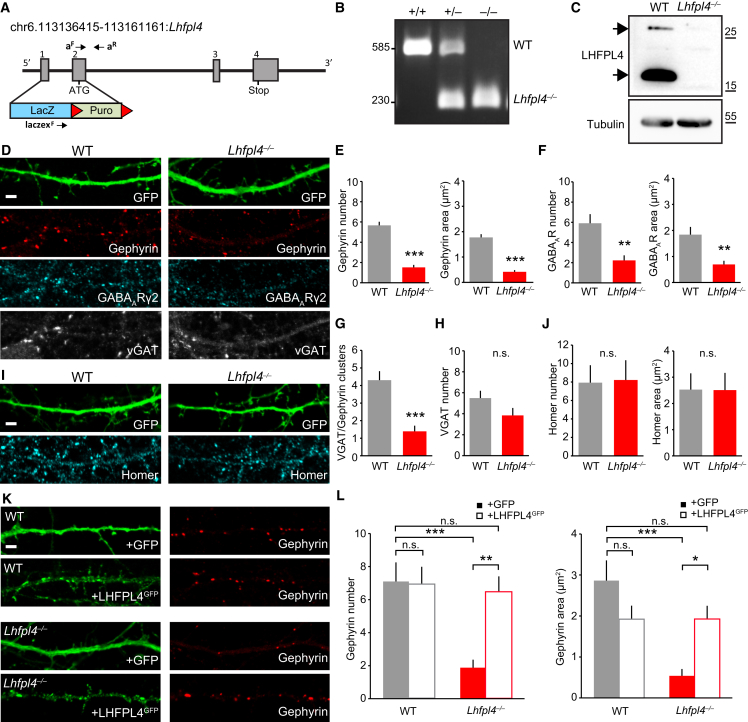
Loss of Inhibitory Synapse Stability and GABAAR Clustering in Lhfpl4−/− Neurons(A) Schematic of the LHFPL4 knockout genetic strategy showing the genotyping primer sites.(B) Genotyping results from WT (+/+), heterozygous (+/−) and homozygous (−/−) animals. The product of primers aF and aR generates a 585-bp band from the WT allele, and the product of laczexF and aR generates a 230-bp band from the Lhfpl4−/− allele.(C) Western blotting of LHFPL4 and tubulin from WT and Lhfpl4−/− mouse brain lysates. Arrowheads indicate the two LHFPL4-specific bands detected.(D and I) Confocal images of dissociated DIV14 (14 days in vitro) WT or Lhfpl4−/− hippocampal neurons transfected with GFP and labeled with antibodies to (D) gephyrin, GABAAR-γ2, and VGAT or (I) homer.(E–H and J) Quantification of (E) gephryin, (F) GABAAR-γ2, (G) VGAT/gephyrin, (H) VGAT and (J) homer synaptic clusters. Cluster number and total immunolabeled area were significantly reduced in Lhfpl4−/− neurons, compared to WT neurons, when labeled for gephyrin (cluster number: from 5.7 ± 0.4 to 1.5 ± 0.2; area: from 1.8 μm2 ± 0.1 μm2 to 0.4 μm2 ± 0.1 μm2; 484/166 WT/Lhfpl4−/− clusters; both p < 0.0001) and GABAAR-γ2 (cluster number: from 5.9 ± 0.9 to 2.2 ± 0.5; area: from 1.8 μm2 ± 0.3 μm2 to 0.7 μm2 ± 0.1 μm2; 636/327 WT/Lhfpl4−/− clusters; p = 0.0011 and 0.0013, respectively). VGAT/gephyrin-positive clusters were significantly reduced in Lhfpl4−/− neurons (from 4.3 ± 0.5 to 1.4 ± 0.3; 294/95 WT/Lhfpl4−/− clusters; p < 0.0001). VGAT cluster number did not significantly change (from 5.5 ± 0.7 to 3.8 ± 0.7; 531/403 WT/Lhfpl4−/− clusters; p = 0.103). In each case, n = 23 WT and 23 Lhfpl4−/− cells from 3 independent preparations. For WT and Lhfpl4−/− clusters, there was no significant change in homer cluster number (8.0 ± 1.9 and 8.2 ± 2.1, respectively; 333/345 WT/Lhfpl4−/− clusters) or area (2.5 μm2 ± 0.6 μm2 and 2.5 μm2 ± 0.7 μm2, respectively; n = 14 WT and KO cells from 3 independent preparations; p = 0.92 and 0.98, respectively). All used Welch t tests.(K and L) Confocal images (K) and cluster quantification (L) of GFP or LHFPL4GFP transfected WT or Lhfpl4−/− neurons labeled with a gephyrin antibody. LHFPL4GFP overexpression completely rescues the reduction of gephyrin cluster number (+GFP: WT, 7.1 ± 1.2; Lhfpl4−/−, 1.9 ± 0.5; 291/80 WT/Lhfpl4−/− clusters; +LHFPL4: WT, 6.9 ± 1.1; Lhfpl4−/−, 6.5 ± 0.9; 291/266 WT/Lhfpl4−/− clusters) and area (+GFP: WT, 2.9 μm2 ± 0.5 μm2; Lhfpl4−/−, 0.5 μm2 ± 0.2 μm2; +LHFPL4: WT, 1.9 μm2 ± 0.3 μm2; Lhfpl4−/−, 1.9 μm2 ± 0.3 μm2) seen in Lhfpl4−/− neurons. n = 14 cells per condition from 3 independent preparations: p < 0.0001 for cluster number and cluster area. Kruskal-Wallis one-way ANOVA.Asterisks indicate results of Dunn’s multiple comparison tests. ∗p < 0.05; ∗∗p < 0.01; ∗∗∗p < 0.001; n.s., not significant. In (E)–(H), (J), and (L), error bars indicate mean ± SEM. Scale, 2 μm.